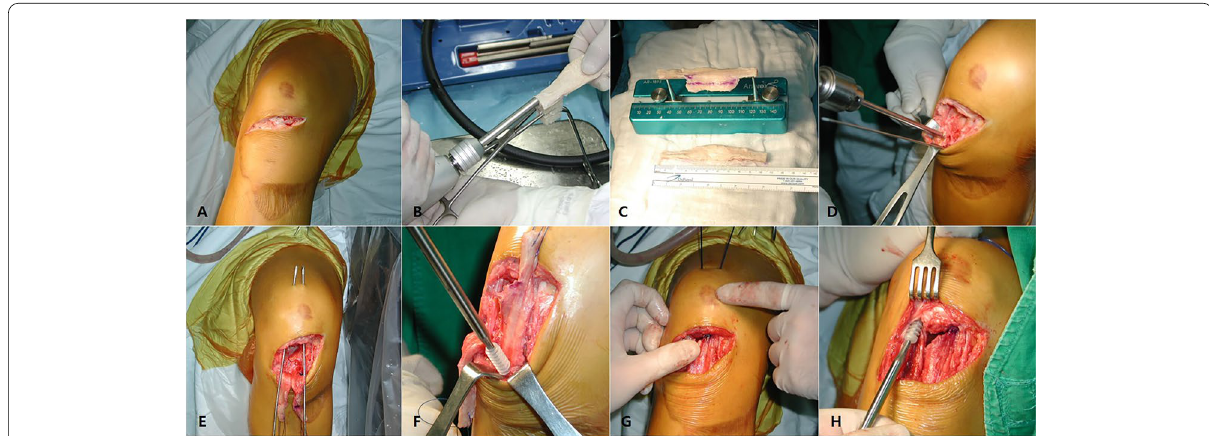
Fig. 3. a-h Operative procedure of patellar tendon reconstruction with double BTB